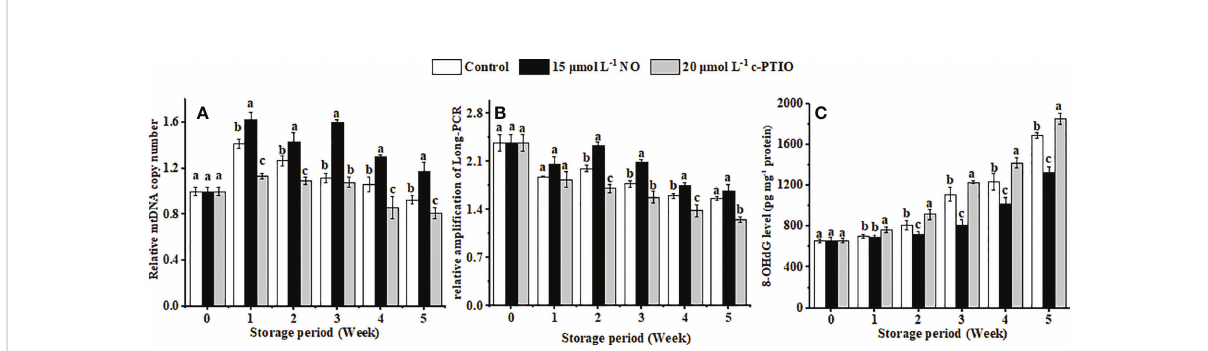
FIGURE 5 Changes in the mtDNA copy number (A) , relative ampli fi cation of long PCR (B) , and the level of 8-OHdG in mtDNA (C) in peaches. Error bars indicate standard errors ( n = 3). Different letters indicate signi fi cant differences among different treatments ( P <